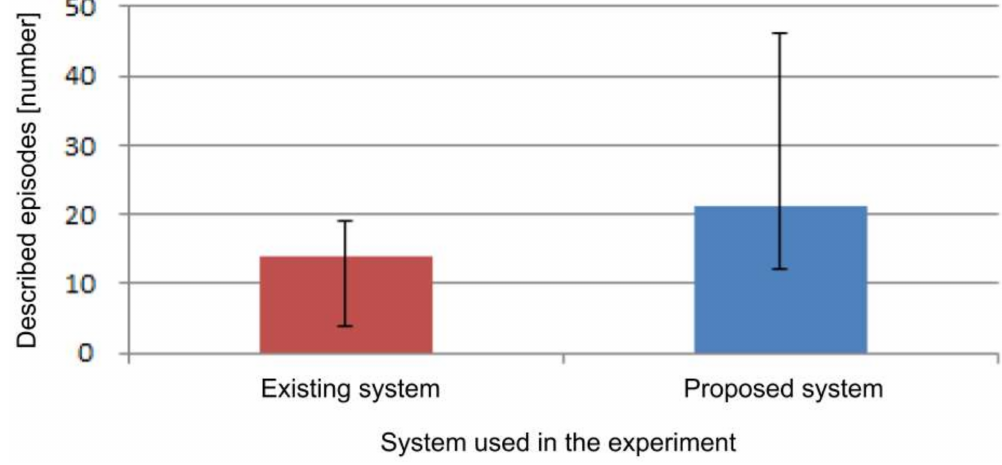
Figure 18. The average number of episodes described by users in Experiment 2-3.